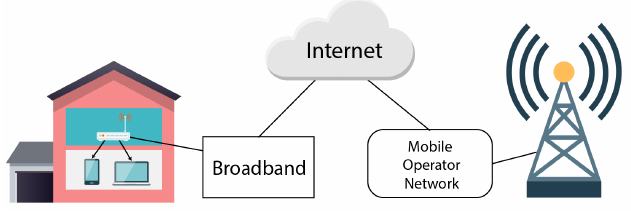
Figure 1. FBS installation within MBS coverage